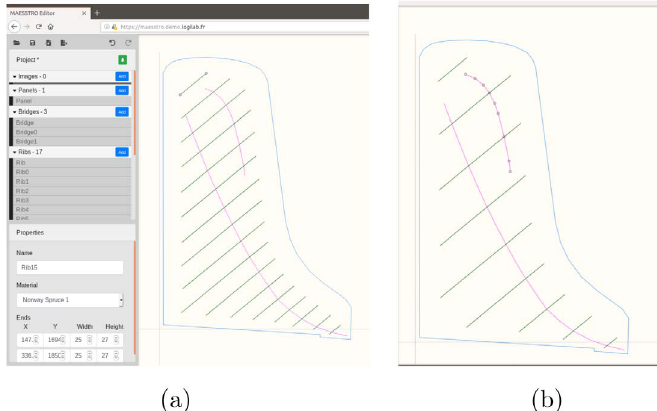
Figure 4. Screen shot of the GUI after completion of the design of the virtual Steinway D. The panel contour is shown in blue, the median line of the bridges in pink and the median lines of the ribs in green. Left (a) is the reference piano, right (b) is the modi fi ed piano 2, labeled as